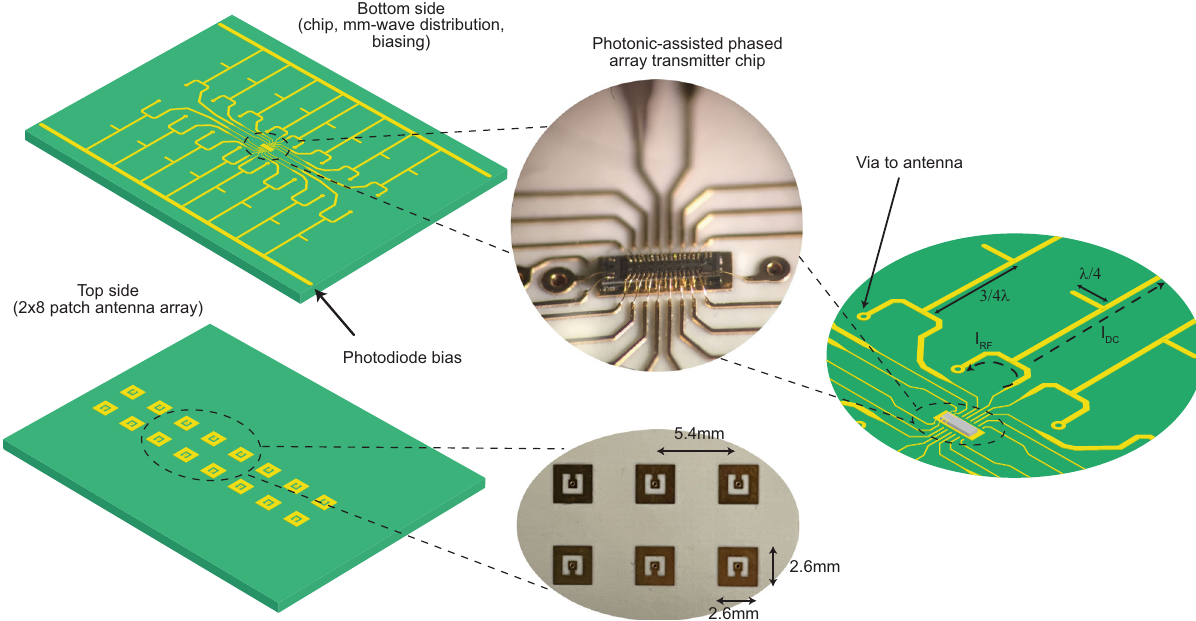
Fig. 3 | PCB with embedded antennas. 4-layer PCB with 2×8 array of patch antennasonthe top sideand the mm-wavedistribution networkand the photonic - assisted mm-wave phased array chip on the bottom side. Power, CLK (Clock) and